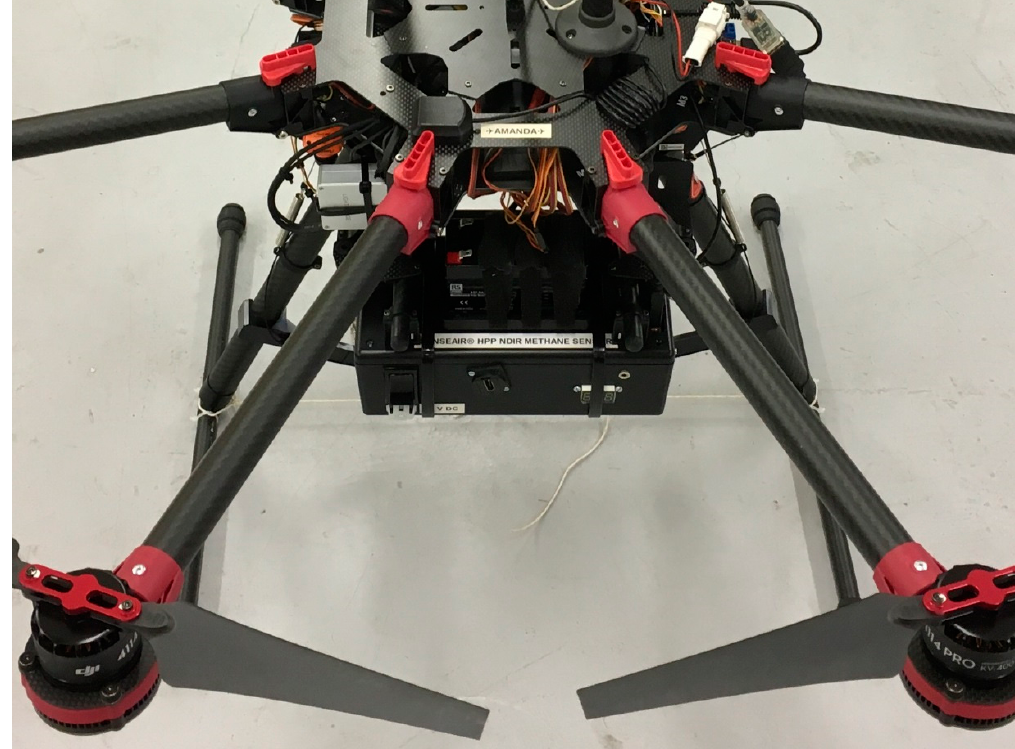
Figure 2. The packaged sensor mounted underneath the centre frame of a DJI Spreading Wings S1000 + octocopter unmanned aerial